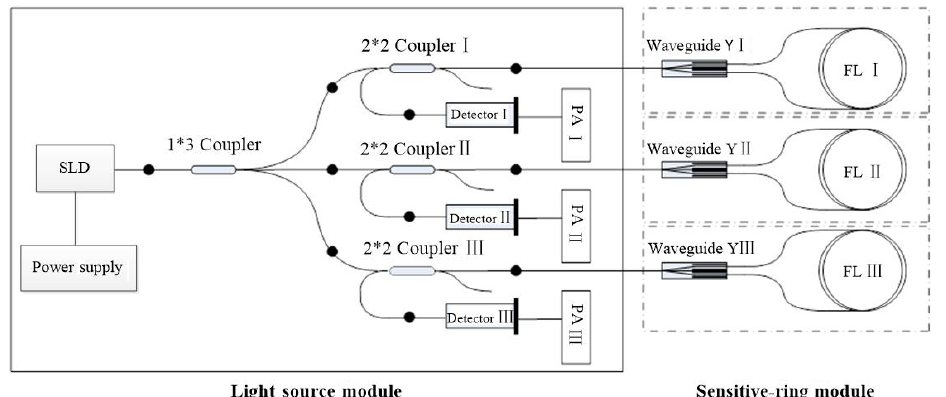
Figure 7. Composition diagram of